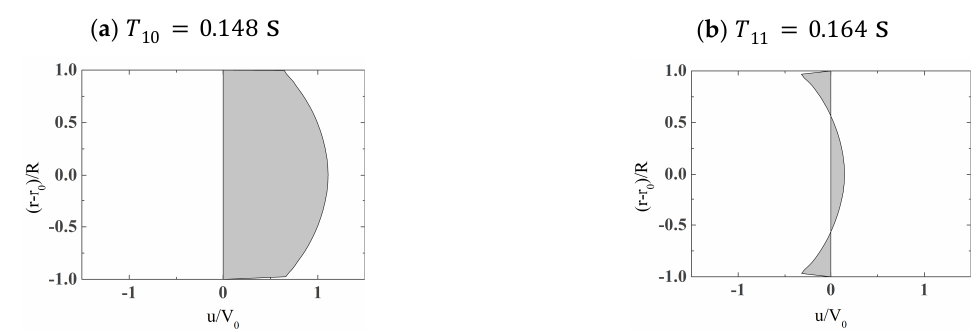
( b ) 𝑇 9 = 0.124 s Figure 20. Local pressure distribution at S1 monitoring position of different time ( 𝑇 8 = 0.116 s and 𝑇 9 = 0.124 s ). Pressure (Pa) ( a ) 𝑇 8 = 0.116 s ( b ) 𝑇 9 = 0.124 s Figure 21. Pressure field evolution on the axis plane of the pipeline ( 𝑇 8 = 0.116 s and 𝑇 9 = 0.124 s ). Stage 5: The wave cycle will be repeated in the pipeline due to inertia, in this stage, the pressure increase wave generated at the valve propagates upstream. Figure 22 is the axial velocity distribution at S 1 monitoring position and Figure 23 is the corresponding local pressure distribution. At( 𝑇 10 = 0.148 s = 𝑇𝑐 + 4.41 × 𝐿/𝑎 ), the pressure head at S 1 position is 24.85 m, a little bigger than that of the original steady state due to the effect of the first part of the wave speed, and the average axial